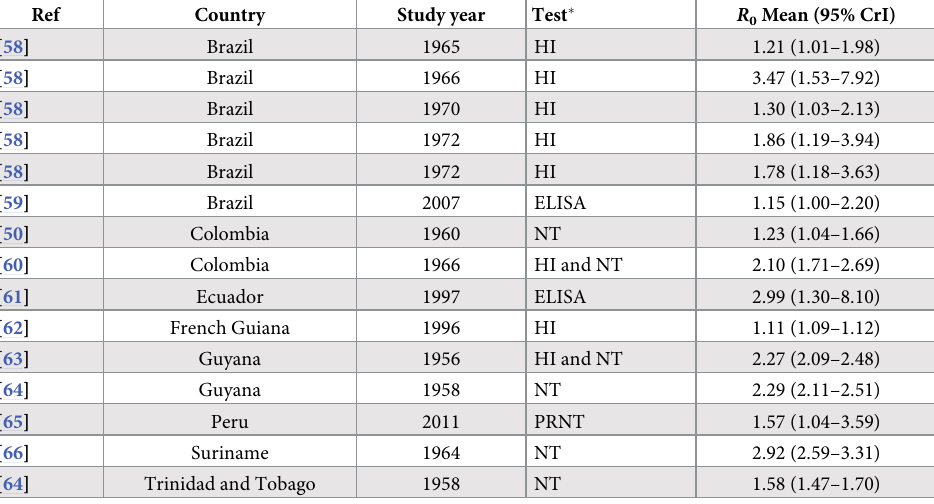
Table 4. Basic reproduction number estimates obtained from seroprevalence studies of